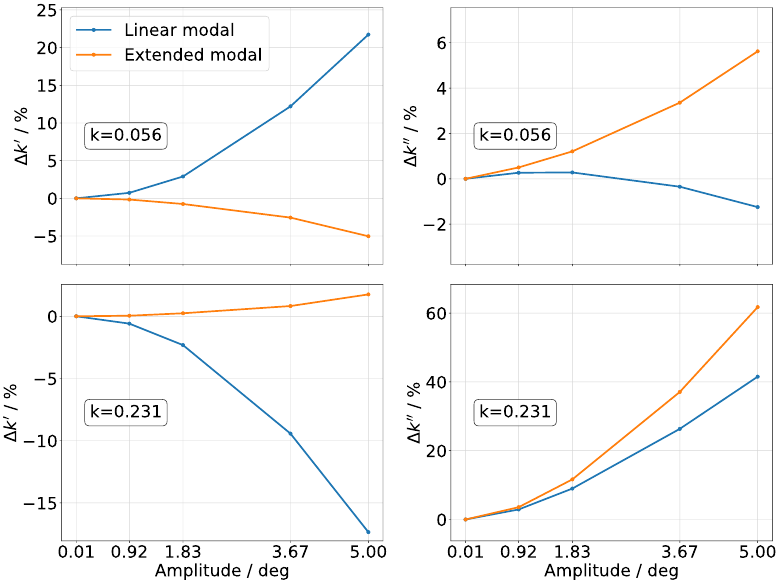
Figure 11. Aerodynamic stiffness and damping over amplitude for Q hh ( 2,1 ) (Inviscid flow, Mach 0.4) Identical stiffness and damping values are shown for all reduced frequencies at the 345 smallest displacement amplitudes. As elaborated, the simulations cover only uncoupled 346 quadratic mode shape components, as the coupled quadratic mode shape components are 347 zero. At a small displacement amplitude, hence, the stiffness is not affected by second order 348